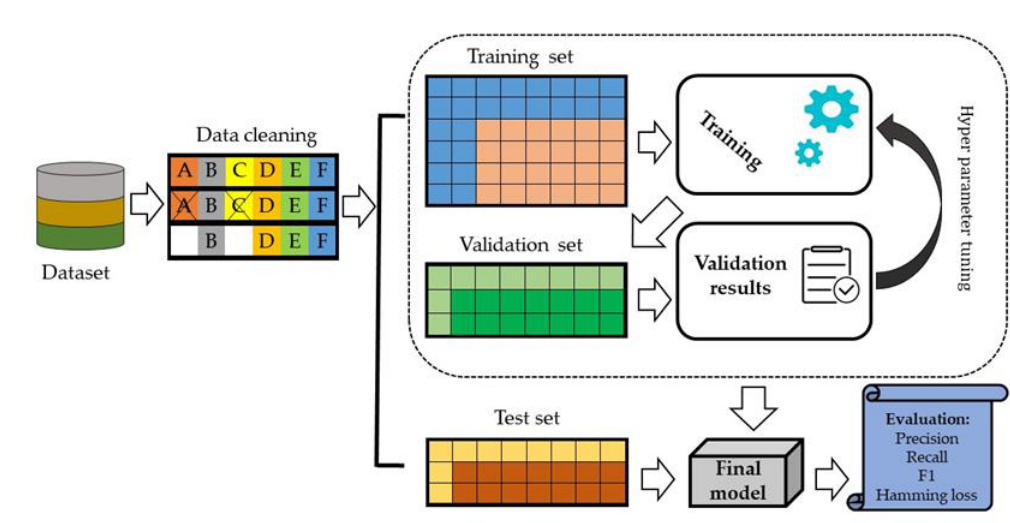
Figure 4. An architecture of the proposed deep learning model.